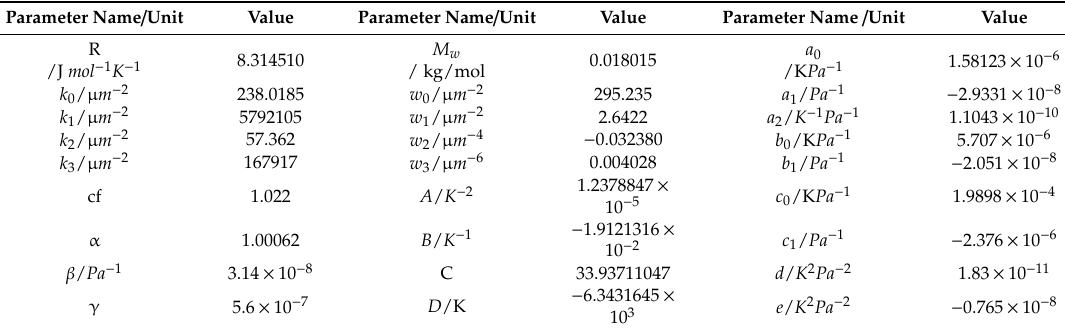
Table 1. Parameter values from each formula